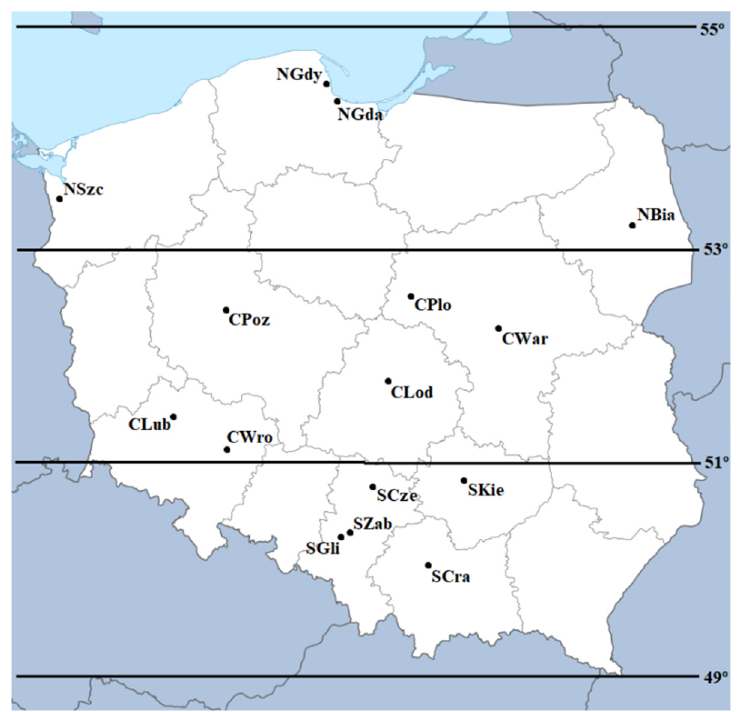
Figure 1. Location of selected measuring stations in selected cities of Poland. Table 1. Measuring station symbols.